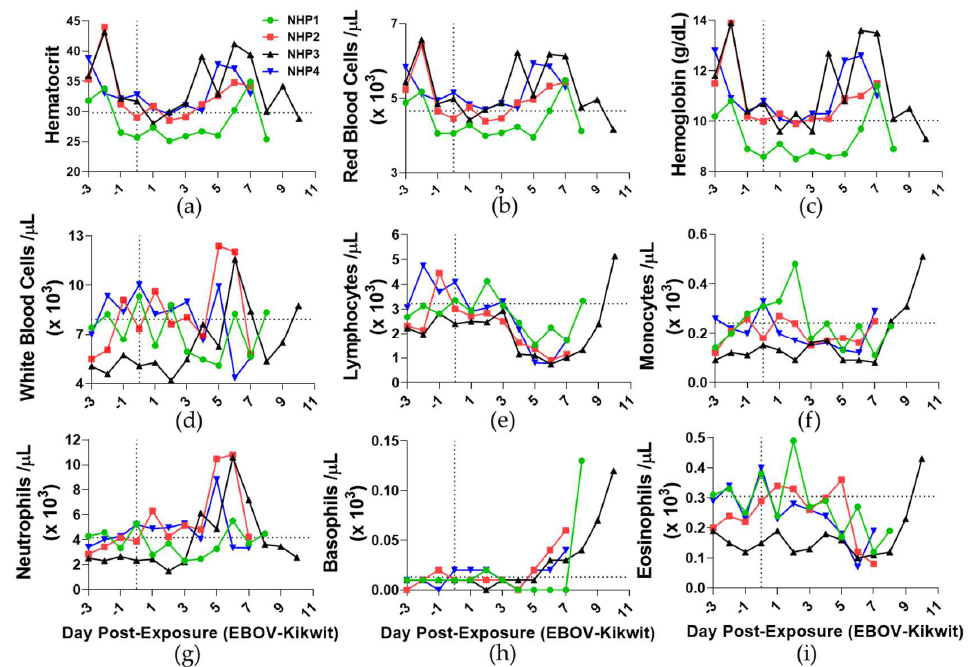
Figure 5. Time course analysis of red blood cell mass and white blood cells from aerosol EBOV-challenged cynomolgus rhesus macaques: ( a ) hematocrit percentage, ( b ) number of red blood cells, ( c ) hemoglobin concentration, ( d ) number of white blood cells, ( e ) number of lymphocytes, ( f ) monocytes, ( g ) number of neutrophils, ( h ) number of basophils, and ( i ) number of eosinophils detected per microliter of blood. DPE 0 is marked by a black vertical dot line. Black horizontal dashed line is average of all animals for DPE 0.